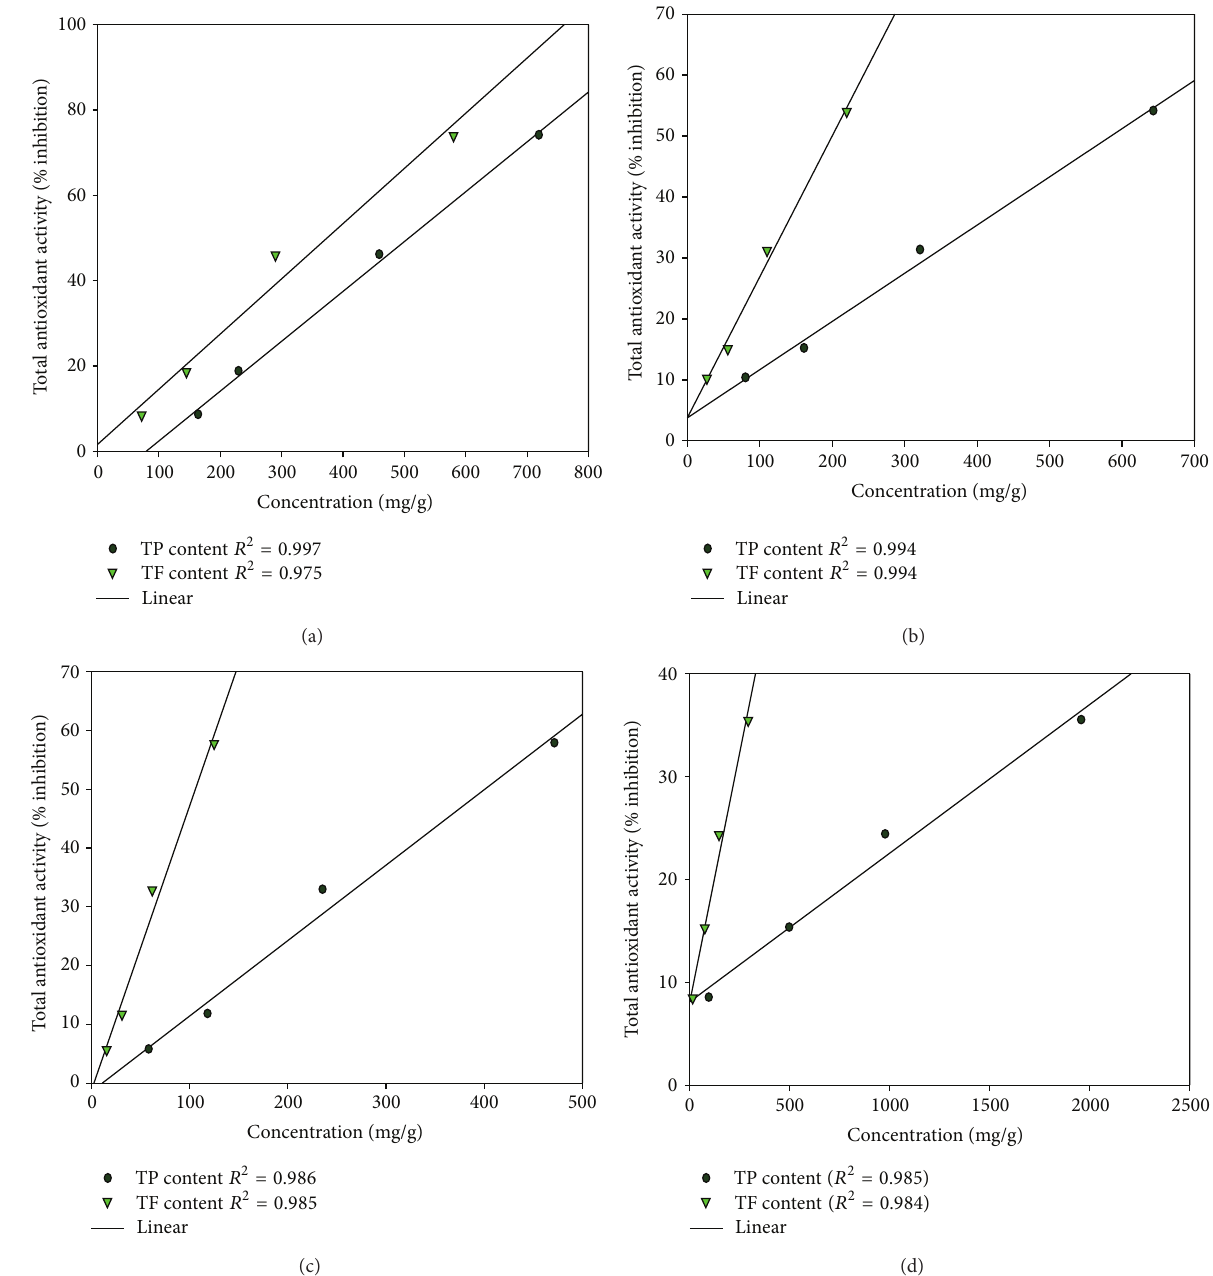
Figure 3: Correlation between total antioxidant activity and polyphenolic (TP&TF) contents of different plant parts of P. fraternus . (a) Ethanolic extract of aerial Part. (b) Aqueous extract of aerial part. (c) Ethanolic extract of root. (d) Aqueous extract of root.